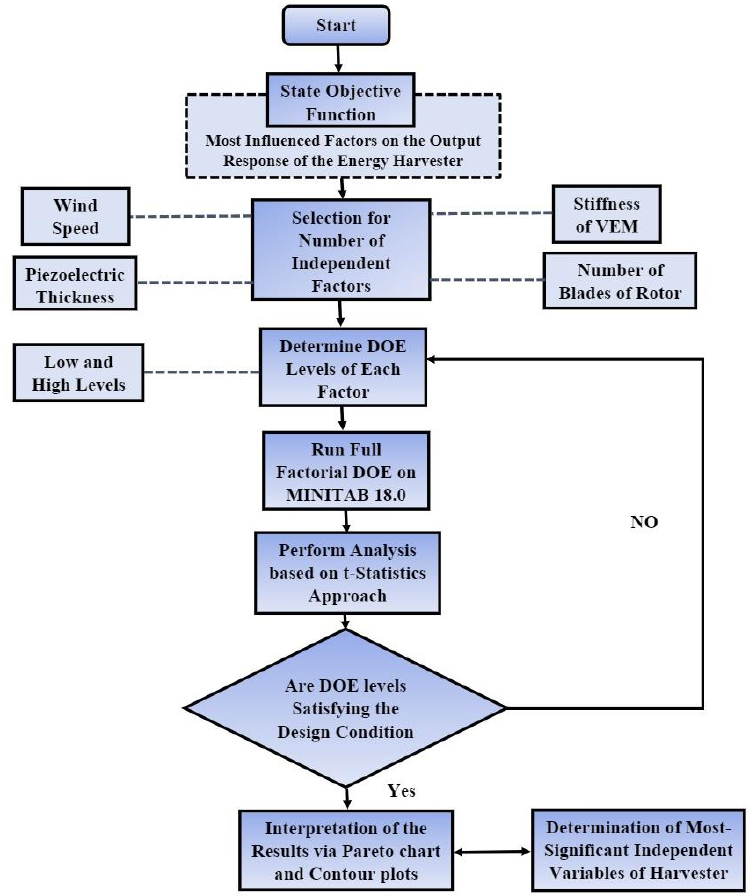
Figure 6. Optimization strategy based on full-factorial DOE.